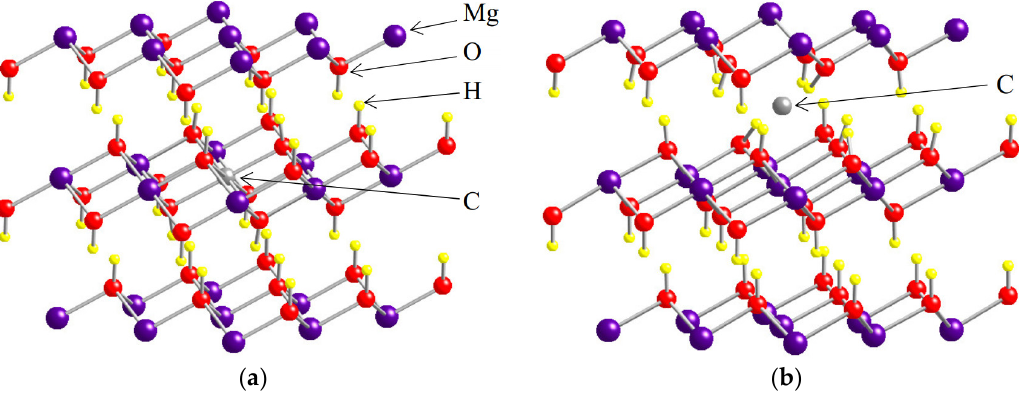
Figure 1. Atomic site of impurity atoms in Mg(OH) 2 , with C used as an example. ( a ) The substitutional (Mg) site; ( b ) the interlayer site.